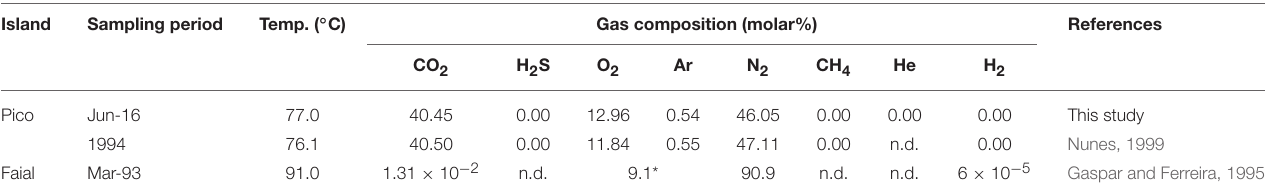
TABLE 1 | Gas composition (molar%) of the fumarolic emissions from Faial and Pico islands. Island Sampling period Temp. ( ◦